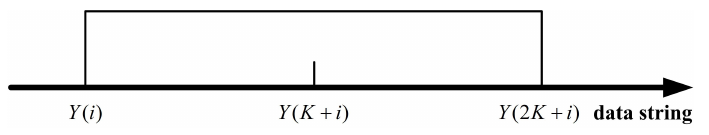
Figure 2. The schematic diagram of the OTA